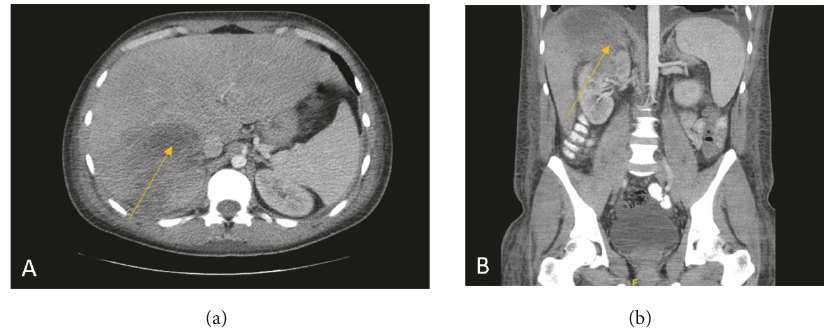
Figure 1: (a) Axial CT image of the abdomen showing a large multiloculated right hepatic mass extending from segment VIII to segment VI (arrow). (b) Coronal image in the same patient showing extension of the hepatic mass into the upper pole of the right kidney.